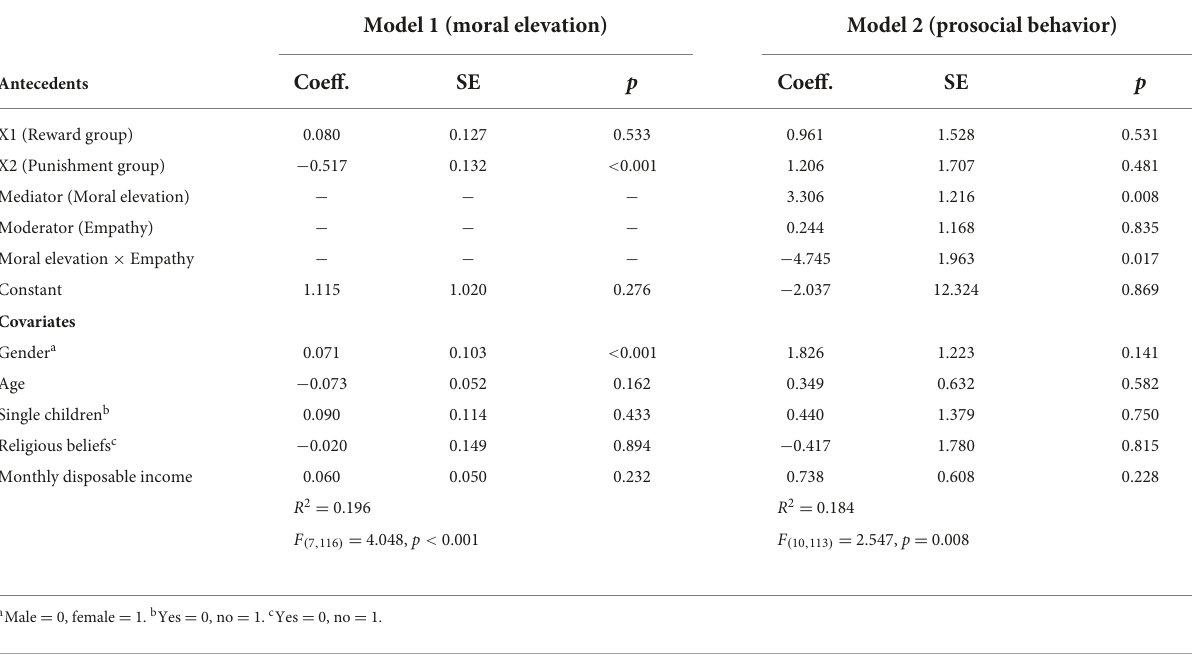
TABLE 2 Testing of the moderated mediation model. Consequent Model 1 (moral elevation) Model 2 (prosocial behavior)